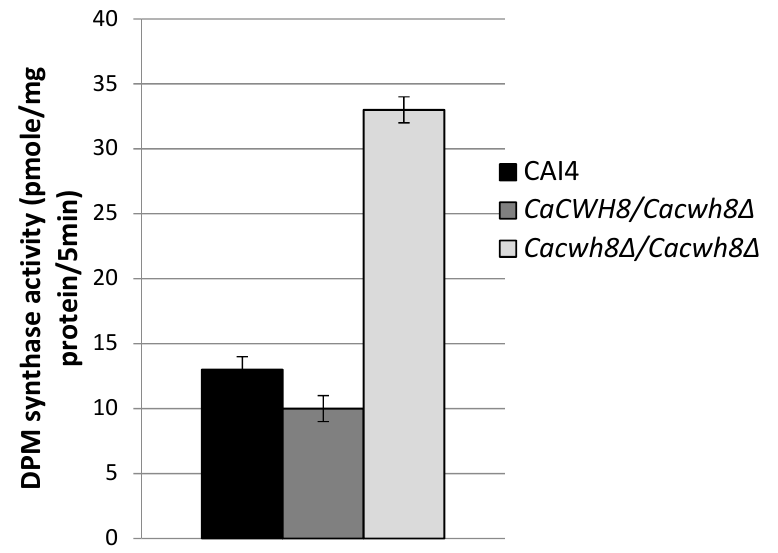
Figure 6. Activity of DPM synthase in membrane fractions from the wild type C. albicans strain CAI4 and the CaCWH8 mutants.